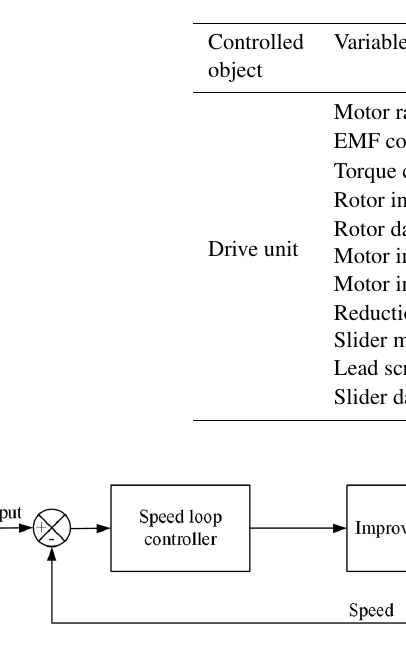
Figure 12. Block diagram of improved drive unit model. Table 2. Base parameters of drive unit.